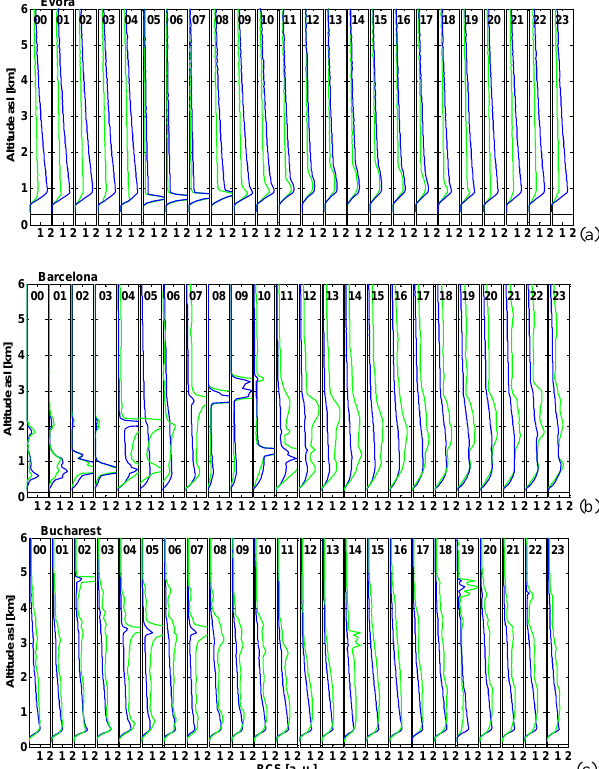
Figure 6. 24h evolution of the hourly RCS profiles (SCC-1 product) at 355 (blue lines) and 532nm (green lines) on J11 in (a) Évora, (b) Barcelona and (c) Bucharest. The numbers in the top of the plots indicate the time in UT. The horizontal black lines represent the station’s altitude